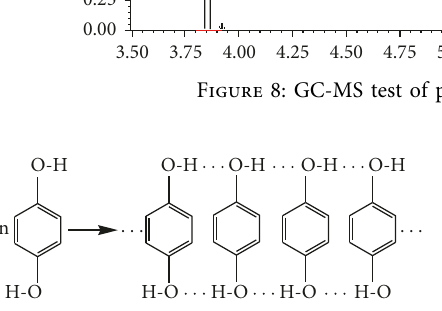
Figure 9: Multimolecule association of hydrogen bonds among hydroxyls of hydroquinone to form